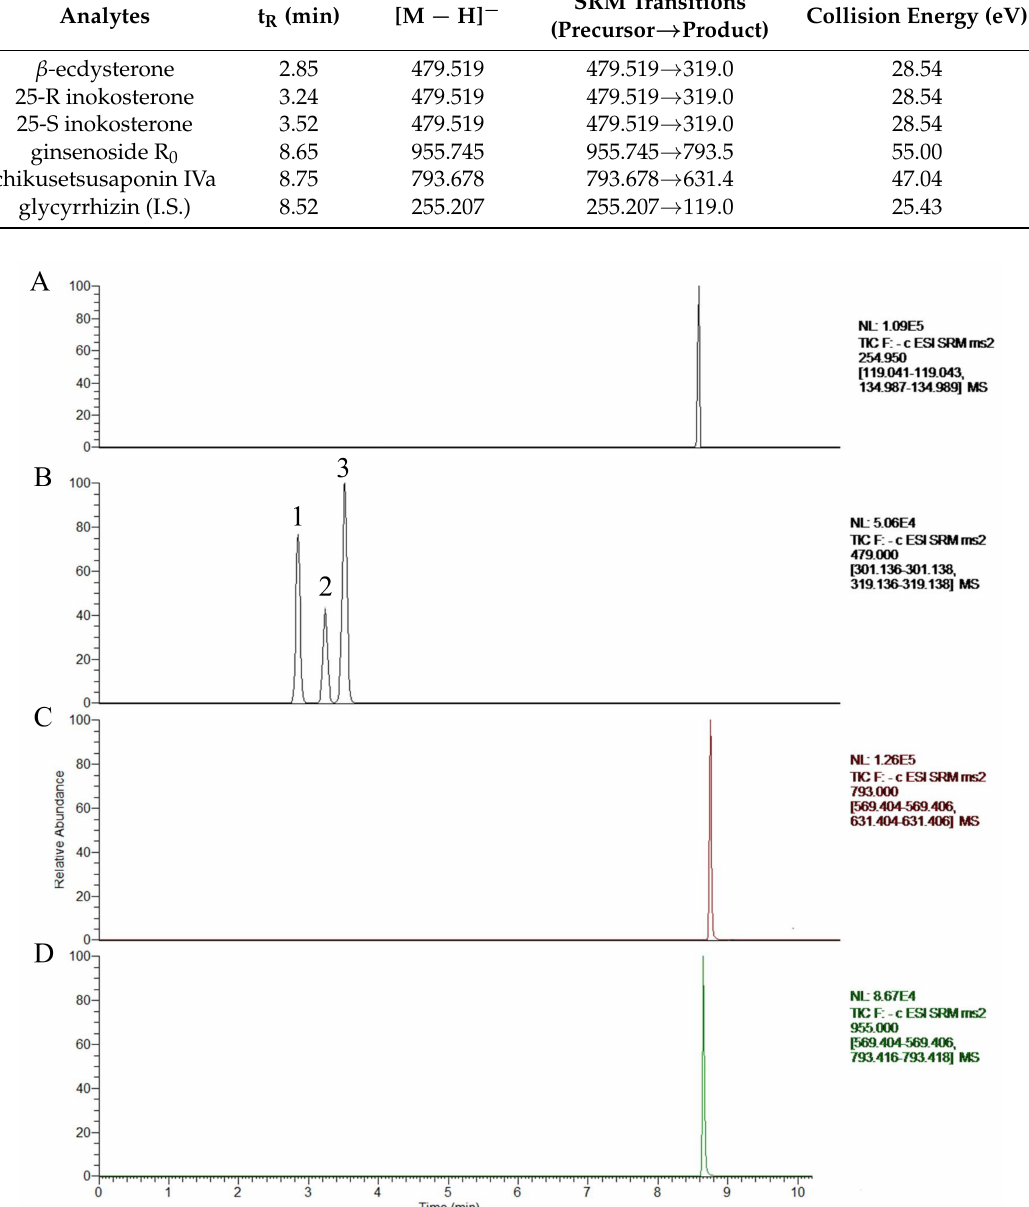
Table 1. Precursor/product ion pairs and parameters for selected reaction monitoring (SRM) of the five analytes and internal standard.